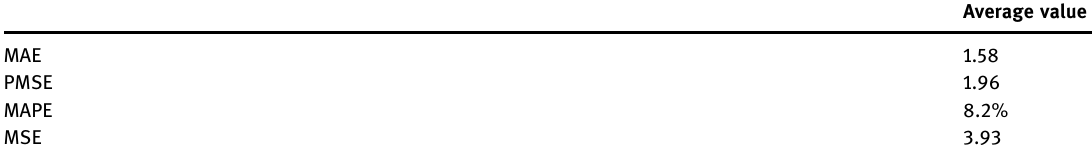
Table 1: Mean value of error